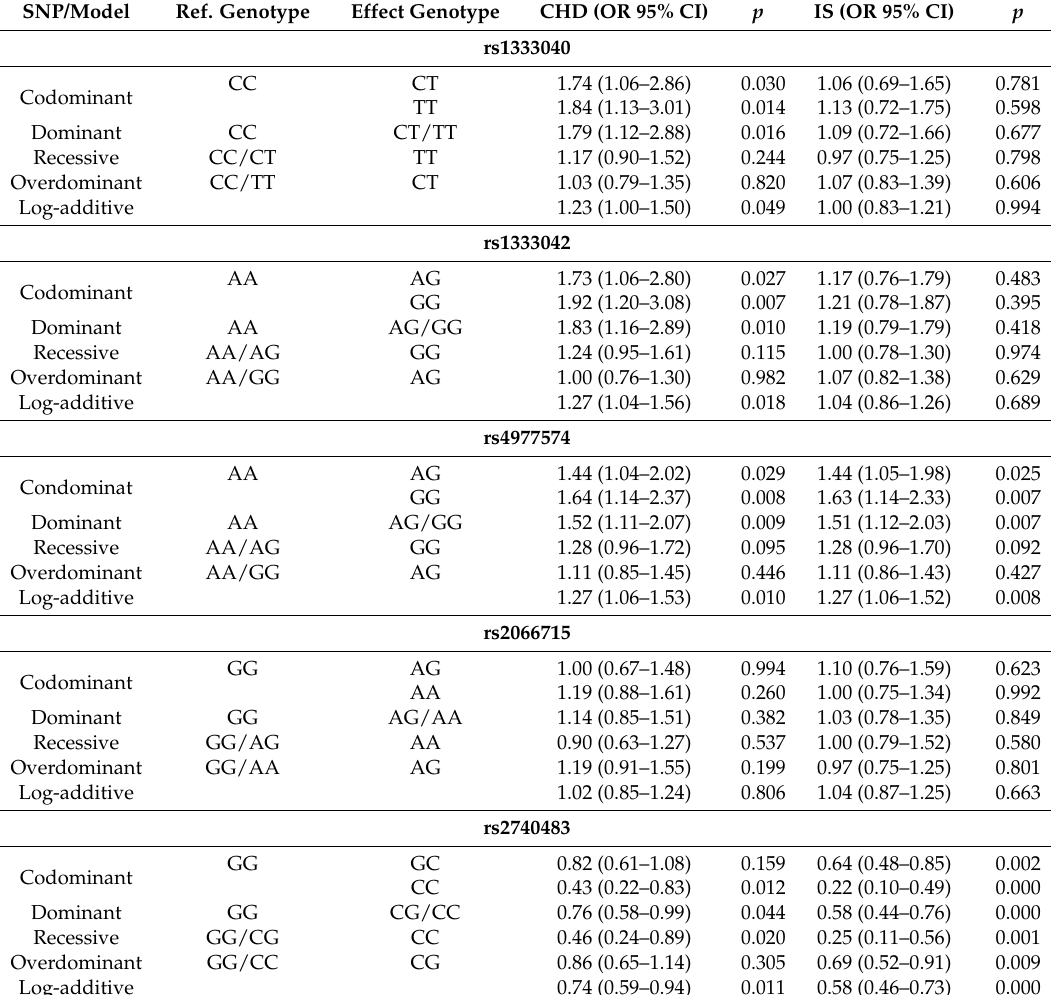
Table 3. Genotypes of the rs1333040, rs1333042, rs4977574, rs2066715 and rs2740483 SNPs and the risk of CHD and IS in different genetic